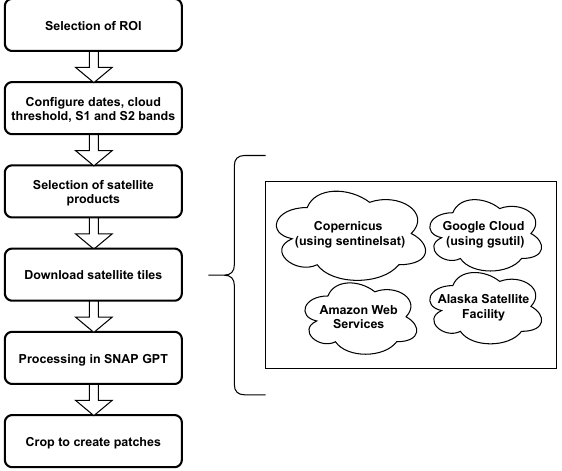
Figure 1. Overview of the proposed ARD